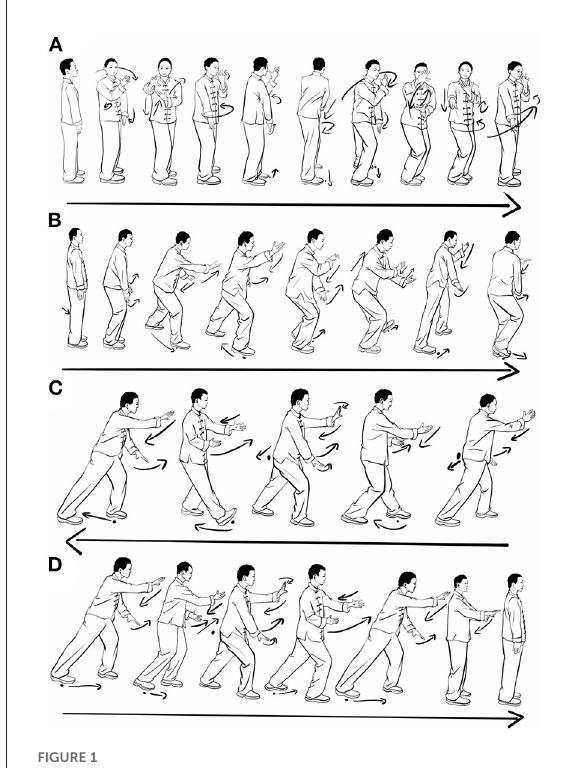
FIGURE1 Pictorial representation of 4 TC movements. (A) Wave hand in the cloud, (B) Leaning fly side, (C) Repulse monkey, (D) Brush knee twist